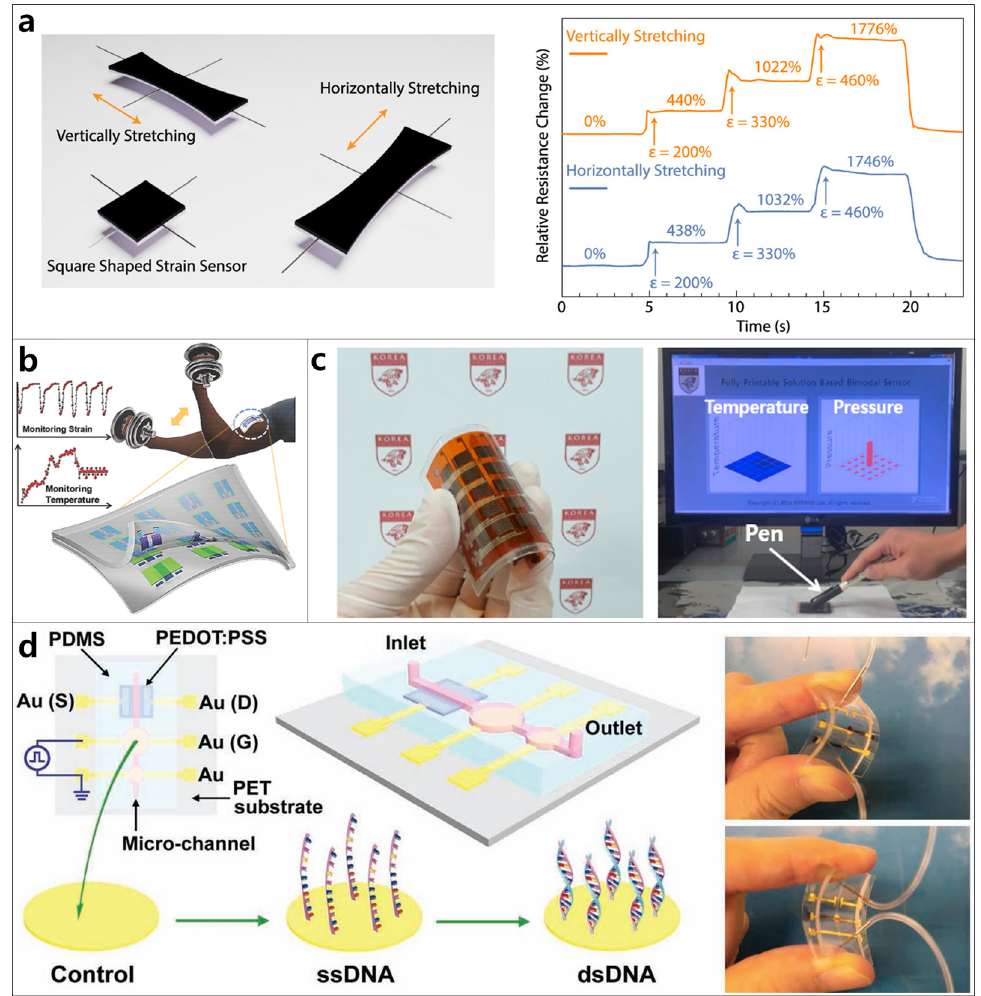
Figure 5. ( a ) Schematic demonstrating omnidirectional sensing capability and relative resistance change over time with the horizontal and vertical tensile stretching of a PANI-based strain sensor (Reproduced with permission from reference [188]); ( b ) schematic of a transparent, stretchable gated sensor array for strain and temperature detection (Reproduced with permission from reference [196]); ( c ) photograph of a flexible sensor array for measurement of pressure and temperature by touching the sensor with a pen (Reproduced with permission from reference [141]); ( d ) an OECT flexible biosensor integrated with a microfluidic system for DNA detection (Reproduced with permission from reference [214]). Table 2. Summary of recent applications of conductive polymer-based flexible sensors.